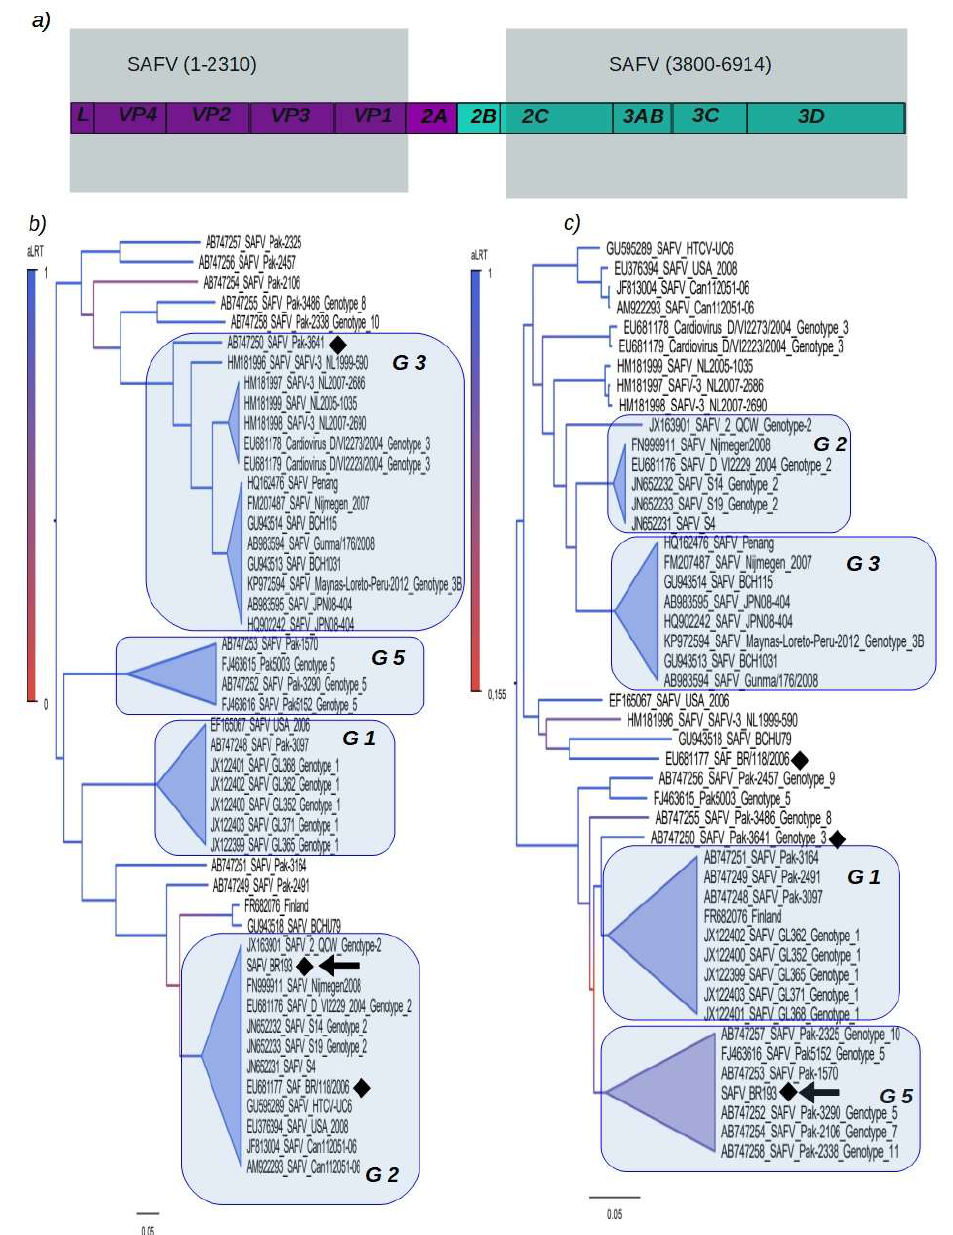
Figure 3. Trees inferred with the partitioned SAFV polyprotein. The polyprotein alignment was divided in two partitions and the region corresponding to the genes 2A and 2B was excluded ( a ). Each partition was used to construct a maximum likelihood (ML) tree. The ML tree inferred using the partition corresponding to nucleotides 1 to 2310 of the SAFV polyprotein shows clusters of sequences corresponding to the main SAFV genotypes ( b ). The ML tree inferred using the partition corresponding to nucleotides 3800 to 6914 of the SAFV polyprotein equally shows clusters corresponding to the main genotypes ( c ). In this topology genotypes 2 and 3 are the closest. Both trees show that some isolates (mainly from Pakistan) are not included in cluster and they locate at the base of different genotypes. Recombinant strains are indicated by filled diamonds and the BR-193 strains is indicated by an arrow. Trees were mid rooted and strains clustering within certain clades, corresponding to SAFV genotypes (indicated by blue colored areas), were collapsed in the tree (blue triangles). The vertical scale bar represents the statistical support for branches was estimated using the approximate likelihood ratio test (aLRT). Horizontal bars represent the amount of nucleotides substitution per site.